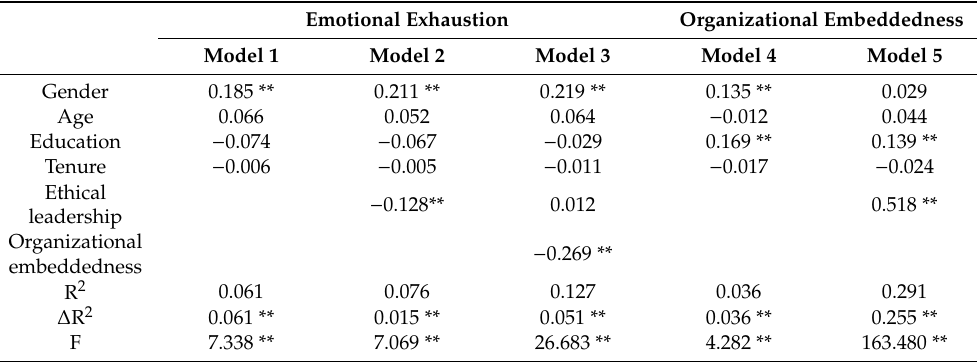
Table 3. Results of mediating e ff ect